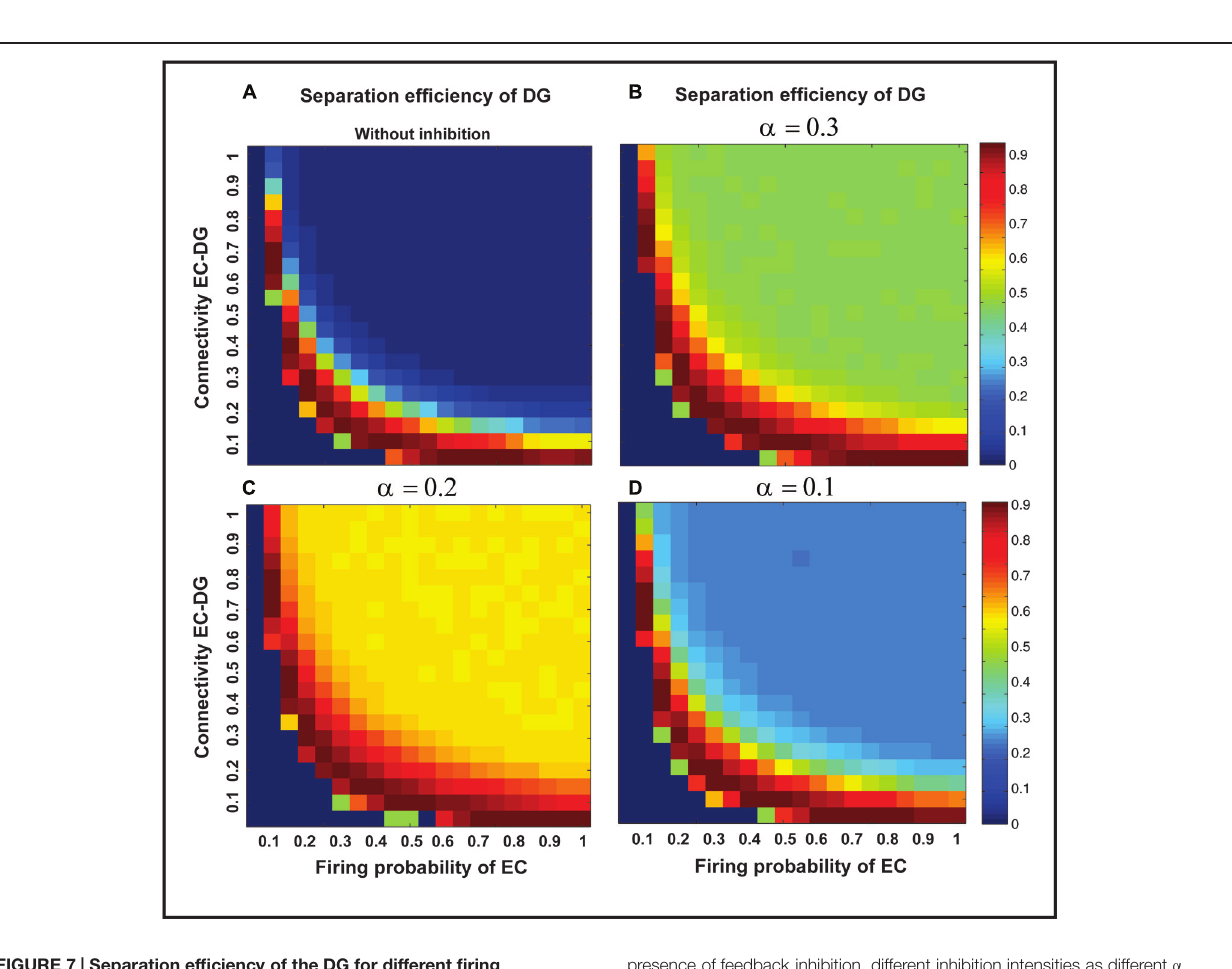
presence of feedback inhibition, different inhibition intensities as different α values leads to different separation efficiency ( α =0.1). (C) α =0.2 (D) α =0.3. Feedback inhibition with α =0.2 leads to high separation efficiency while decrease in α value (high inhibition intensity) causes deficiency in separation of pattern by suppressing the activity of neurons in the